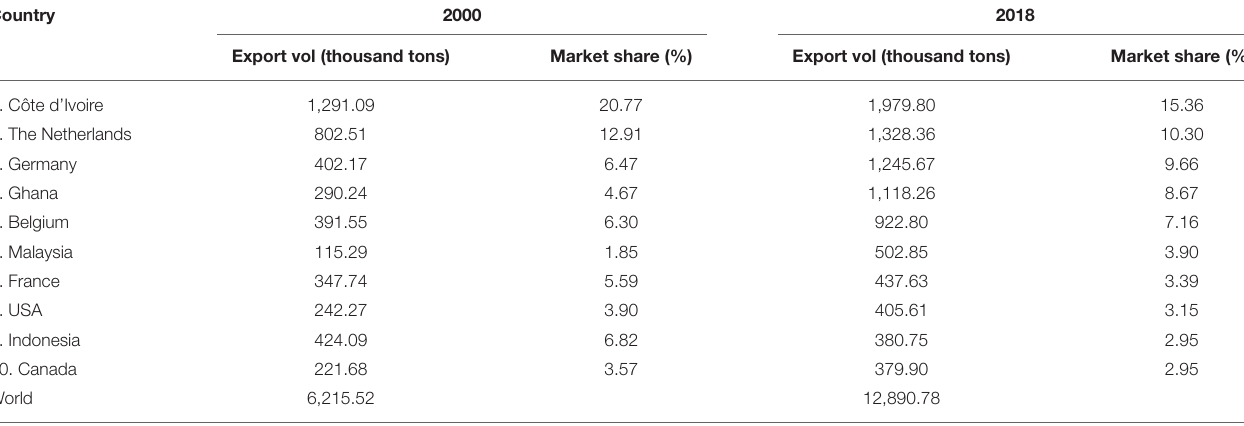
TABLE 2 | Export volume and market share of cocoa exports for major exporting countries, 2000 and 2018. Country 2000